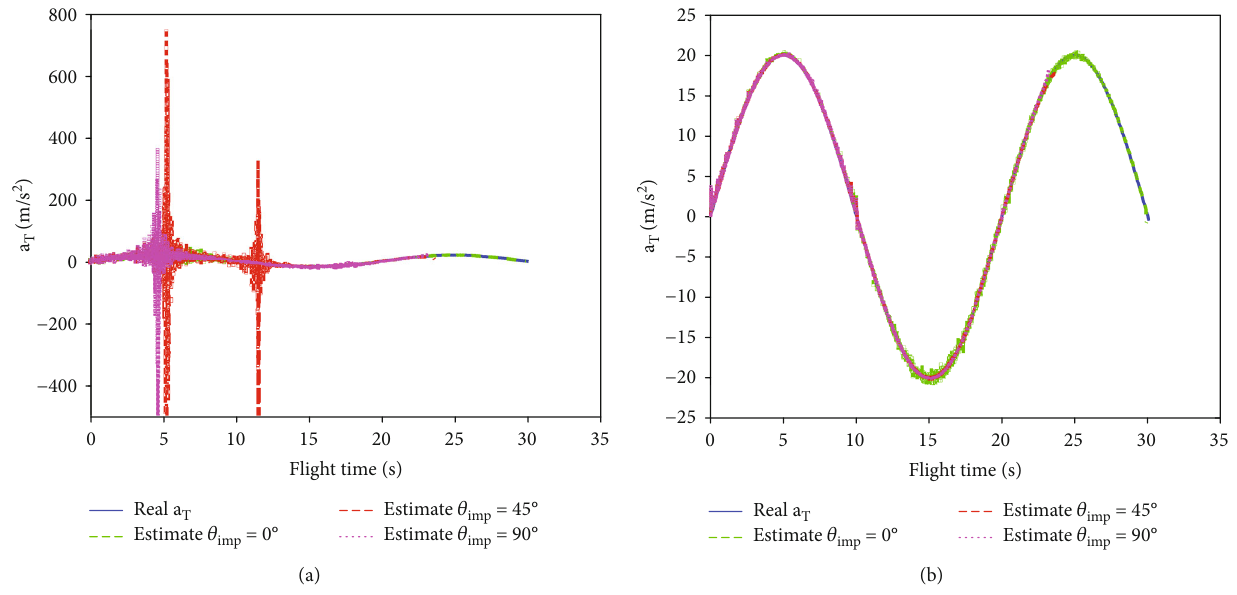
Figure 2: Comparison of two target maneuver estimation strategy: (a) estimation algorithm [27]; and (b) estimation algorithm